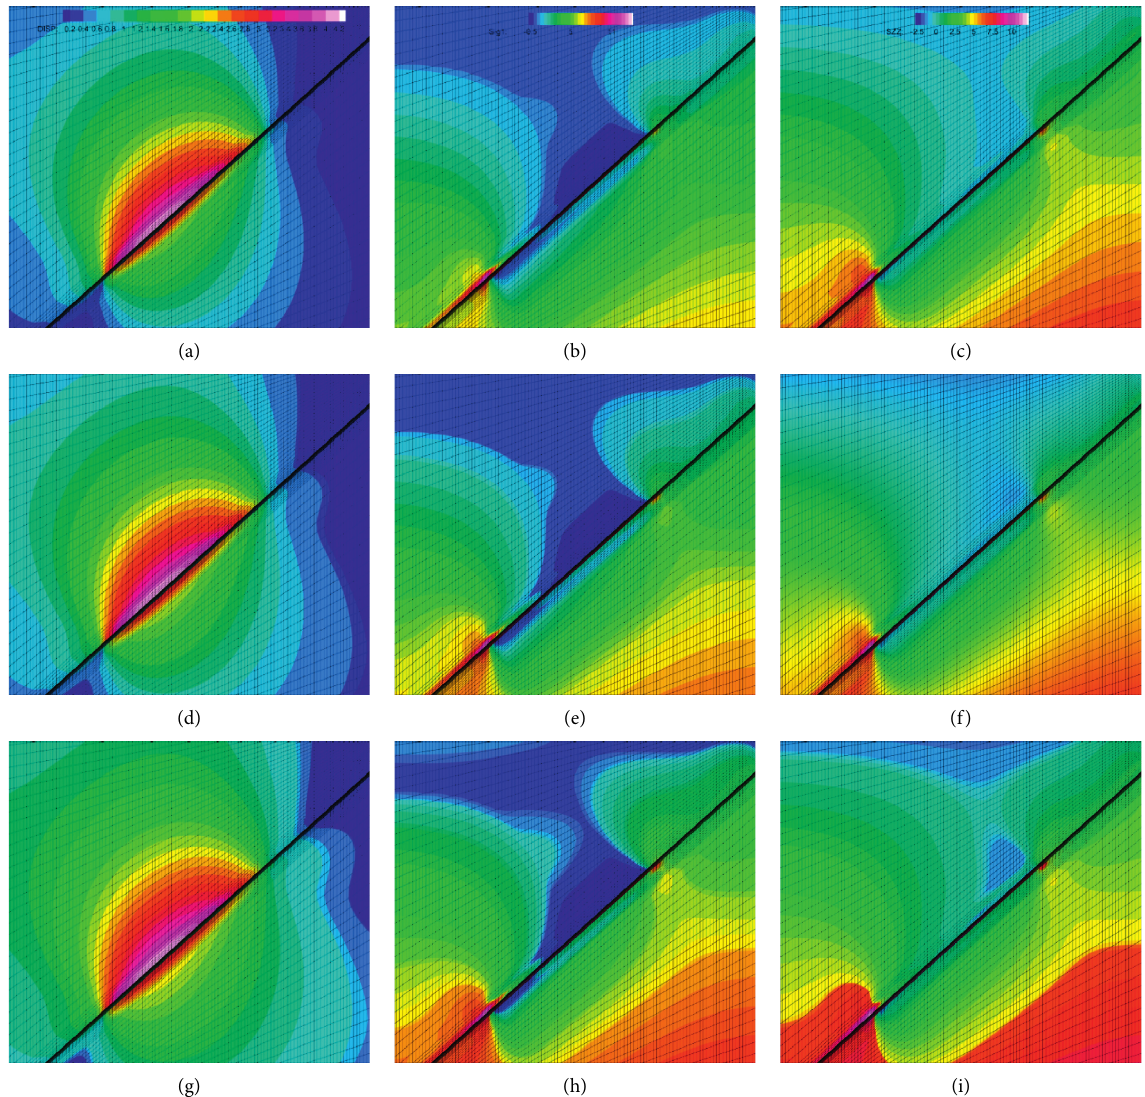
Figure 5: Numerical simulation test results of roof structure migration law in large-inclined coal seam. (a) Distribution characteristics of strain field of minimum parameters. (b) Distribution characteristics of maximum principal stress field of the most group parameter. (c) Distribution characteristics of the most small parameter lead direct stress field. (d) Strain field distribution characteristics of intermediate parameters. (e) Distribution characteristics of maximum principal stress field of intermediate group parameters. (f) Distribution char- acteristics of intermediate parameter straight stress field. (g) Strain field distribution characteristics of maximum group parameters. (h) Distribution characteristics of maximum principal stress field with maximum group parameters. (i) The distribution characteristics of the maximum group parameter lead stress